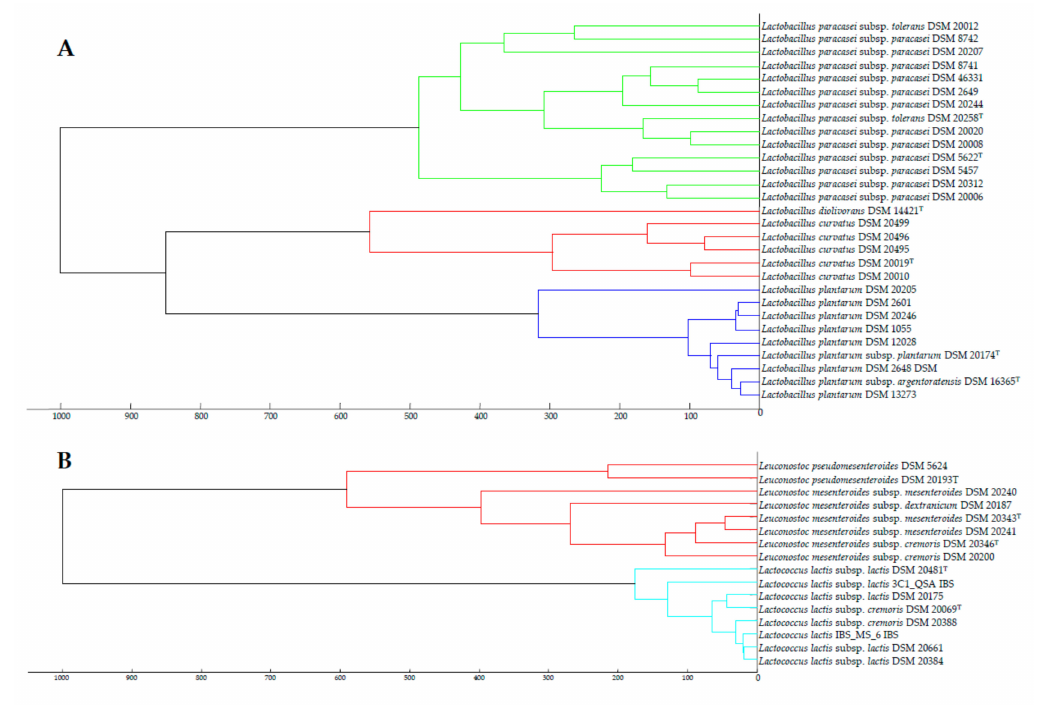
Figure 4. Cluster analysis of MALDI-TOF MS spectra of the strains belonging to the species identified in this study which are included in the biotyper 3.0 database within genera Lactobacillus ( A ) and Leuconostoc and Lactococcus ( B ). Distance is displayed in relative